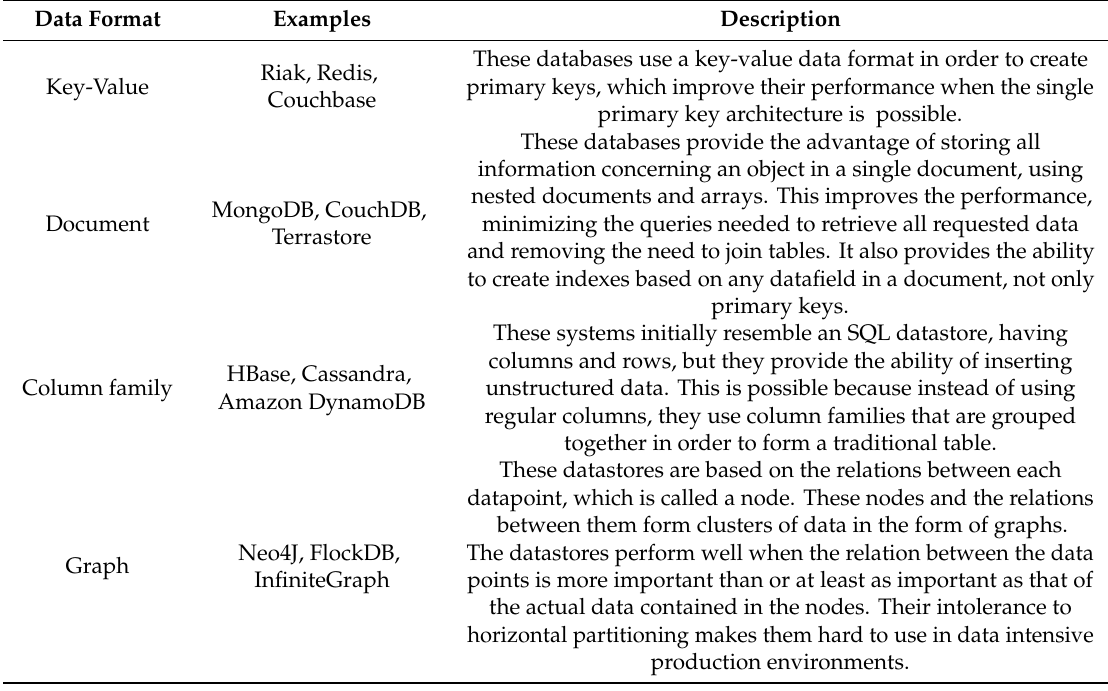
Table 1. NoSQL datastore families, examples and short descriptions